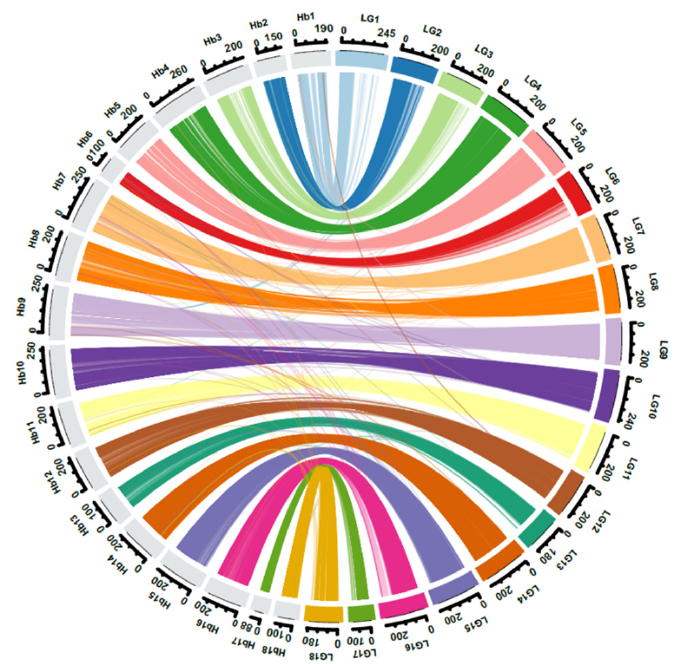
Figure 3. Synteny and collinearity of 17,310 markers between the RRII 105 × F4542 linkage map and the reference genome of Hevea brasiliensis. The outer circle indicates the genetic lengths of linkage groups LG1 through LG18 in cM and the physical lengths of pseudomolecules Hb1 through Hb18 in